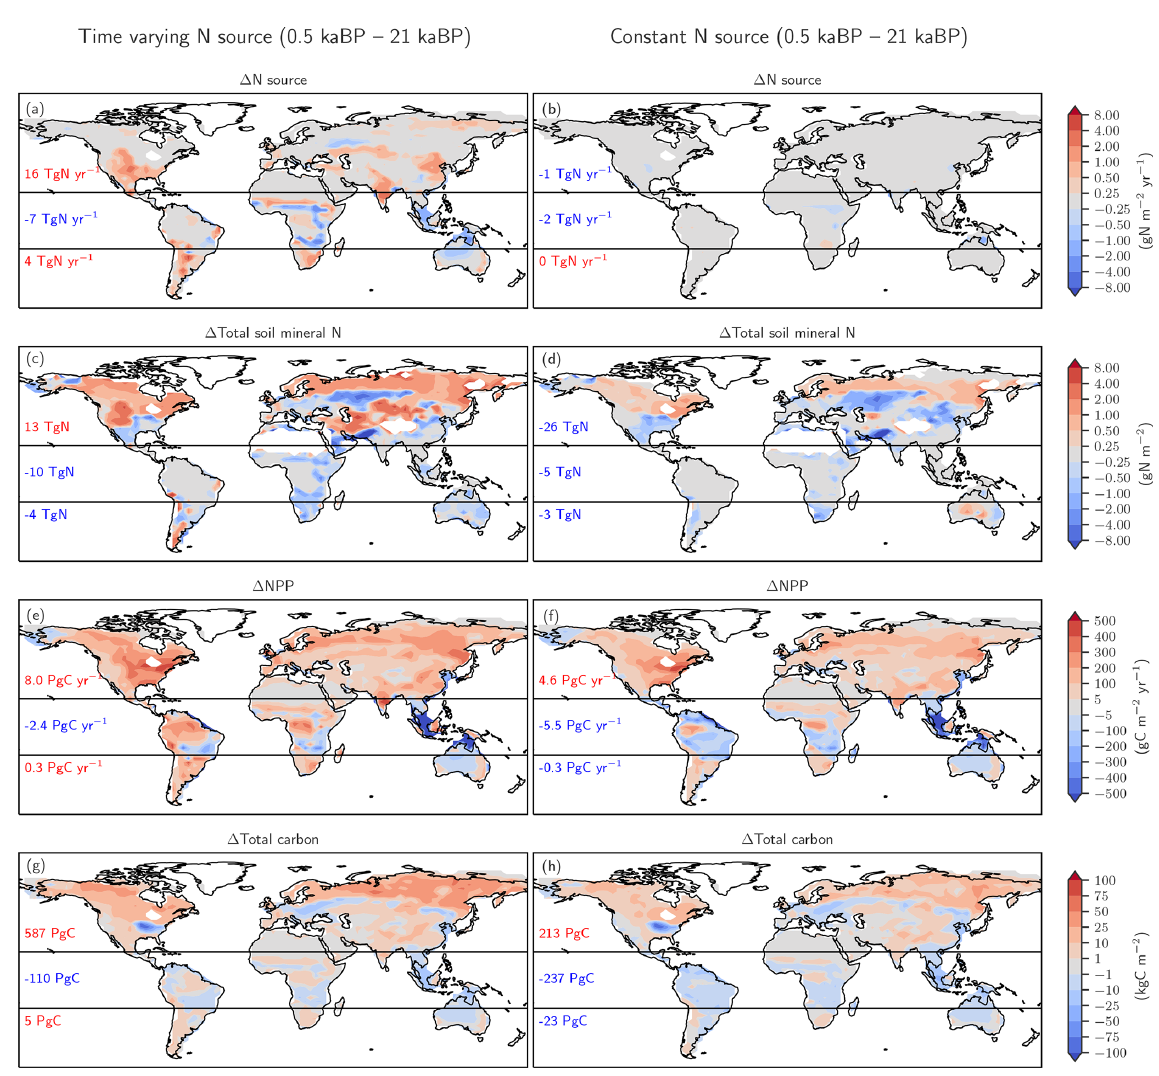
Figure 6. Biological nitrogen fixation allowed to adjust to demand (left) versus time-invariant N source (right). The figure shows simulated deglacial changes (0.5ka minus 21ka) for the standard setup of LPX-Bern(v1.4N) (left column) and a setup where the nitrogen source flux is kept constant at values simulated for the Last Glacial Maximum (right column) for the same variables shown in Fig. 5. Note that a decreasing N source is shown in panel (b) for land areas lost due to deglacial sea-level rise and in some tropical cells where mineral soils with a relatively high N source are replaced by peat with a relatively low N